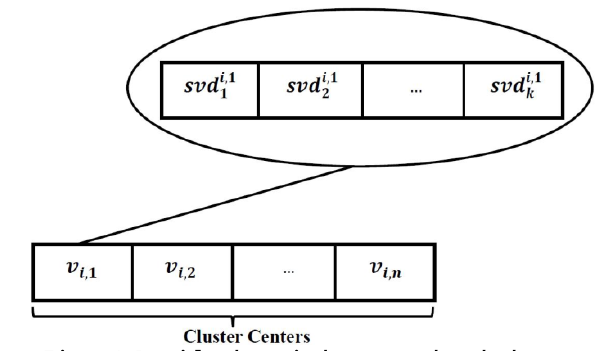
Figure 1. Particle scheme in the proposed method.